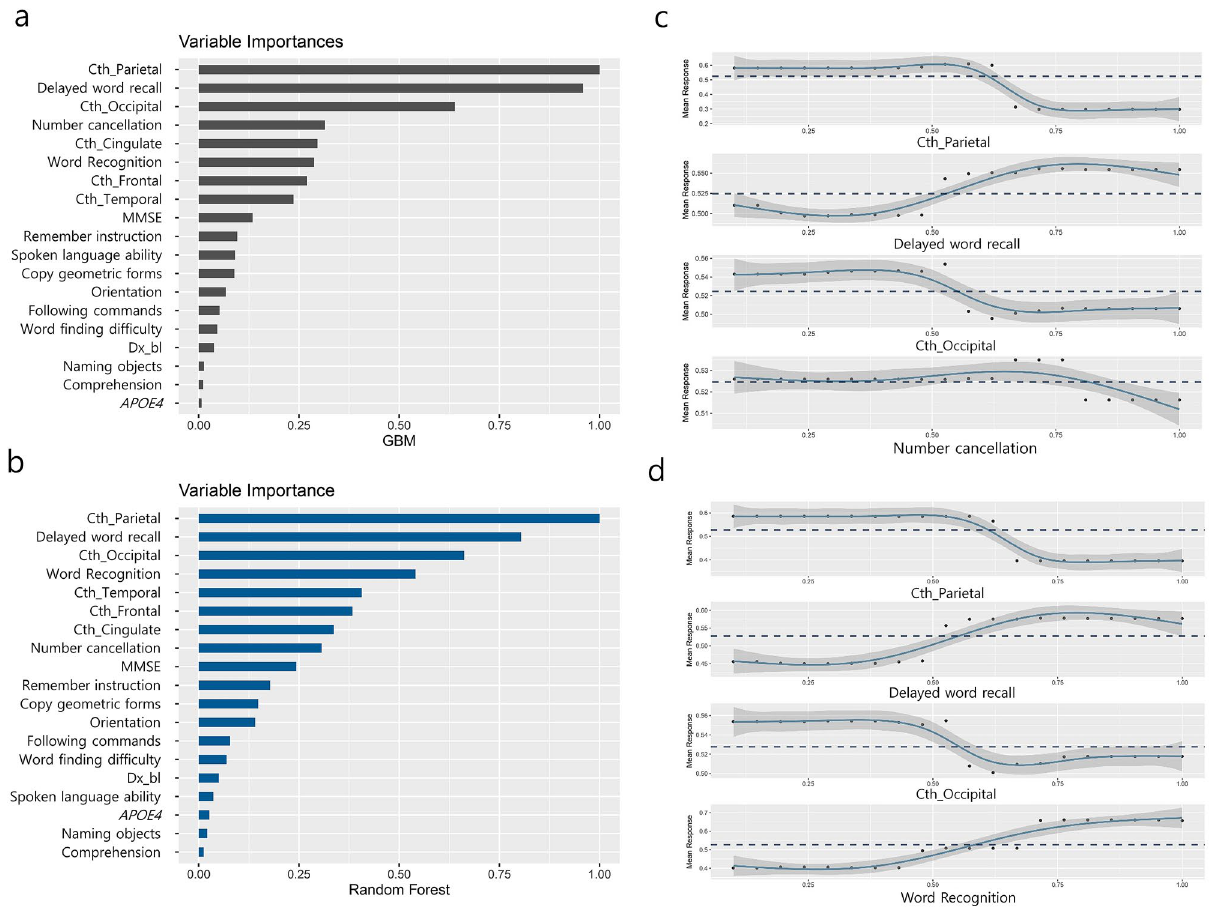
Figure 2. Variable importance plot for model 6 ( a ) GBM and ( b ) RF; and partial dependence plot for model 6 ( c ) GBM and ( d ) RF. MMSE mini-mental state examination, APOE4 Apolipoprotein E 4 genotype, Cth cortical thickness, GBM gradient boosting machine, RF random forest. Each plot was made using the R